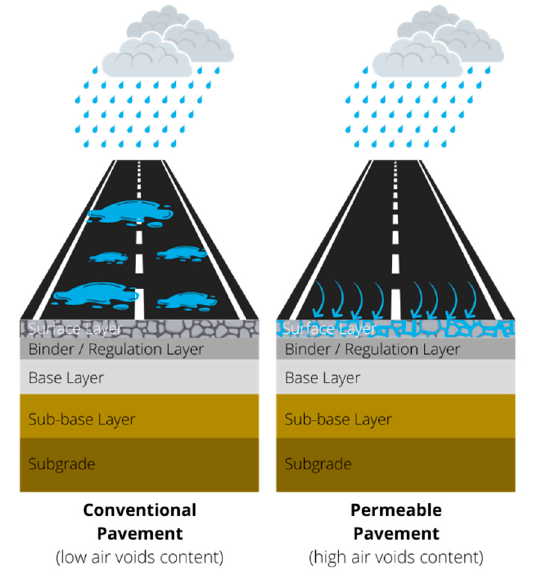
Figure 3. Permeable vs conventional pavements.